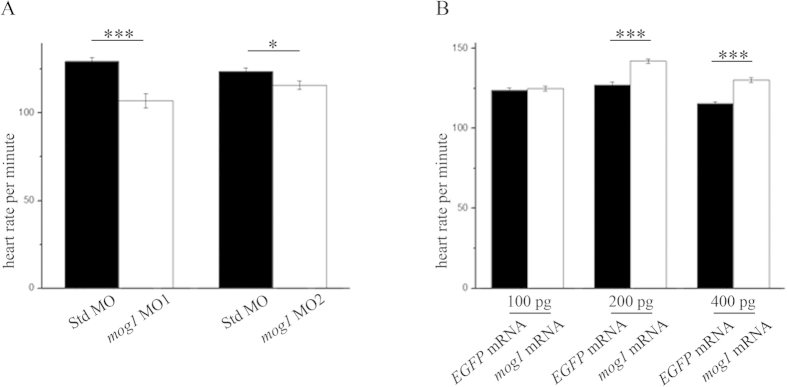
Mog1 regulates the heart rate (HR).(A) Knockdown of mog1 expression by mog1 MO1 and MO2 caused reduction of the HR at 72 hpf. HR: 107 ± 4 bpm, n = 31 for mog1 MO1 morphants; 129 ± 4 bpm, n = 35 for control Std MO morphants (***P < 0.0001); 115 ± 2 bpm, n = 22 for mog1 MO2 zebrafish; 123 ± 2 bpm, n = 21 for control Std MO zebrafish (*P < 0.05). (B) Overexpression of mog1 in zebrafish embryos caused an increase of the HR at 120 hpf. HR at a dose of 100 pg: 124 ± 1 bpm, n = 33 embryos for mog1 mRNA; 123 ± 1 bpm, n = 35 embryos for control EGFP mRNA (P > 0.05). HR at a dose of 200 pg: 142 ± 1 bpm, n = 44 embryos for mog1 mRNA; 127 ± 2bpm, n = 33 embryos for control EGFP mRNA (***P < 0.0001). HR at a dose of 400 pg: 130 ± 2 bpm, n = 39 embryos for mog1 mRNA, 115 ± 1 bpm, n = 37 embryos for control EGFP mRNA (***P < 0.0001). Data were shown as means ± SEM from three independent experiments. We have noted that the heart rate varies from one experiment to another experiment (probably due to fluctuation of temperature), therefore, the comparison of the heart rate was always made between two groups in the same set of experiments.